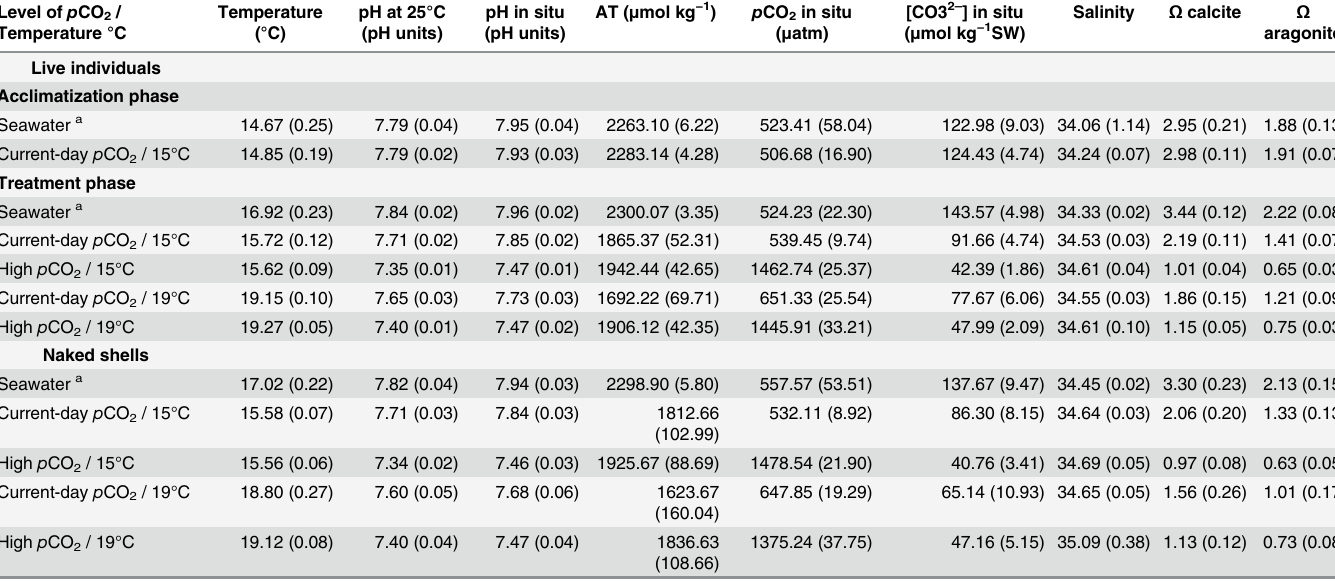
Table 1. Average ( ± SE) conditions of the seawater used to maintain small juveniles of Concholepas concholepas during the acclimatization and treatment phases. The higher p CO 2 is based on rate of change in pH predicted by the most extreme scenario (RCP8.5 scenario) of atmospheric CO 2 for the beginning of the next century. See Meinshausen et al. [34] for further